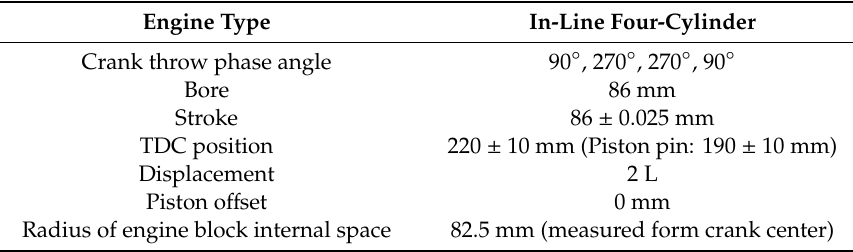
Table 2. Design specifications for VCR engine mechanism.